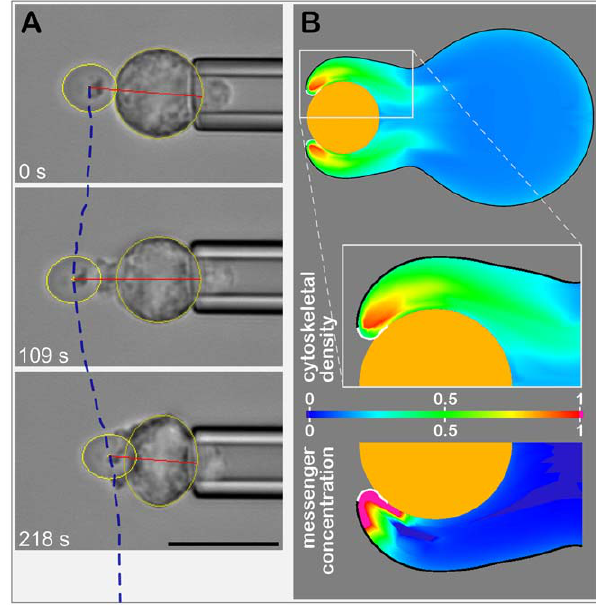
Figure 1. Overview of single-cell/single-target experiment and computer model. ( A ) Example videomicrographs of a phagocytosis experiment showing the typical initial response of a pipette-held neutrophil to adhesive contact with a zymosan particle. The dashed line depicts part of the time-dependent positional trajectory of the target center (measured relative to the opposite edge of the main cell body, red line). The scale bar is 10 m m. ( B ) Snapshot of a computer simulation. The zymosan particle is modeled as a rigid sphere. The insets enlarge the pseudopod engulfing the particle. The leading, white membrane patch marks the region where a signaling messenger is produced. The coloring of the lamella interior reflects the relative density of the cytoskeletal actin network (top half) and the relative concentration of the messenger (bottom half).